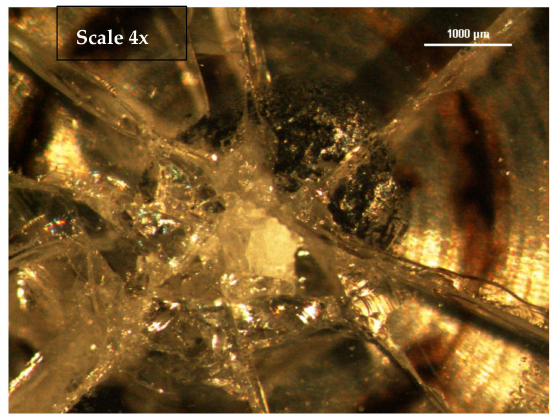
Figure 10. Lower JB on z axis after the test, AA6081 spindles. The micrographs reported on Figures 10 and 11 were obtained by a stereo microscope. A partial removal of the sapphire itself is visible.